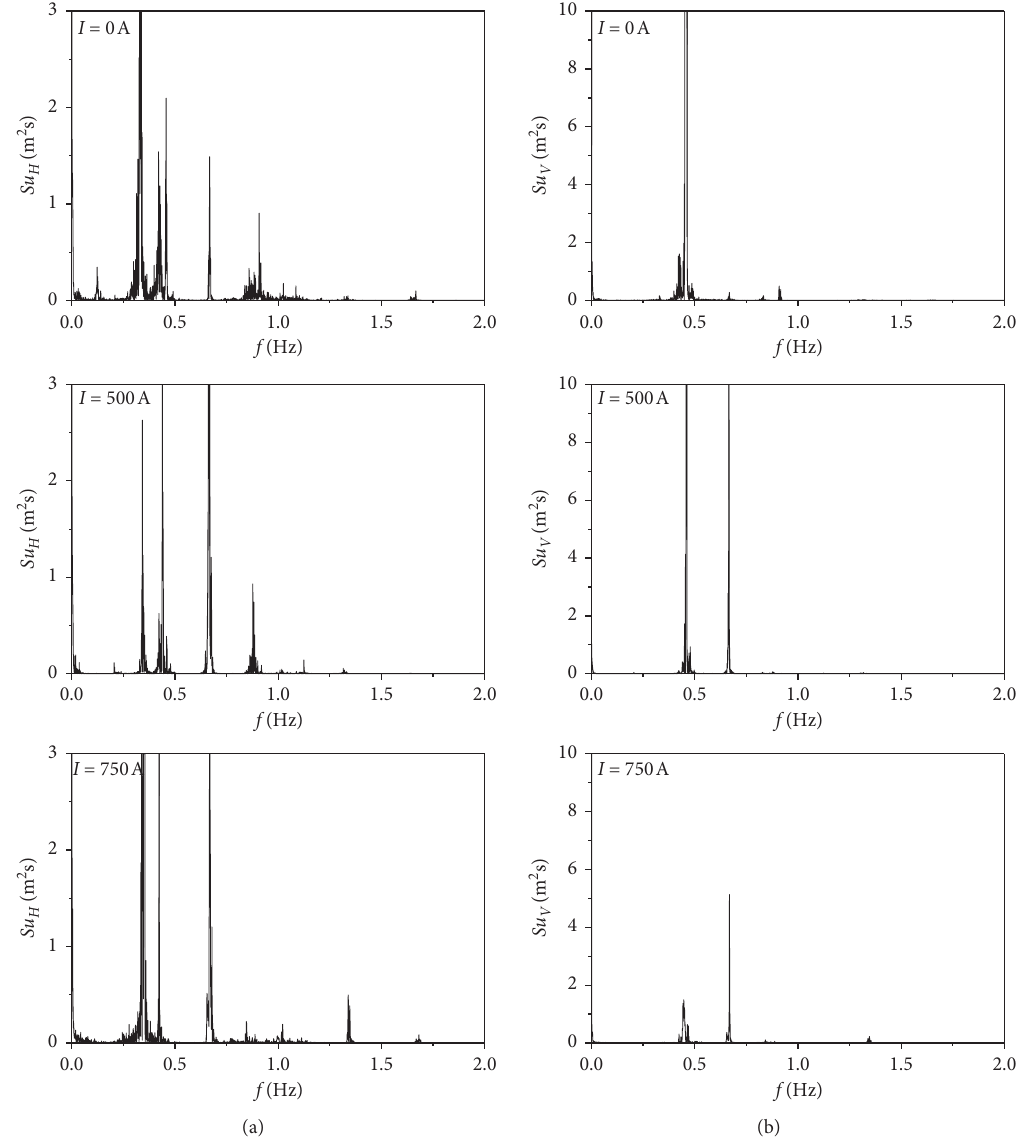
Figure 11: Displacement spectra at the subspan 3 midpoint of subconductor 1 under different current intensities ( α � 30 ° ): (a) horizontal displacement and (b) vertical